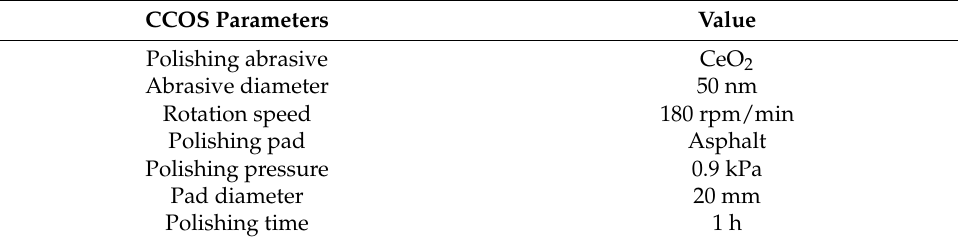
Table 2. Computer controlled optical surfacing (CCOS) technique parameters of sample 3, 4.